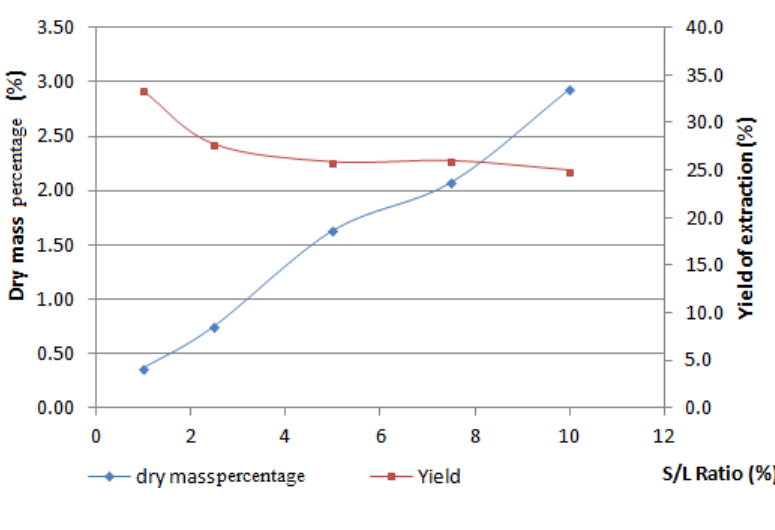
Figure 1. Soluble material extracted in function of Solid/Liquid